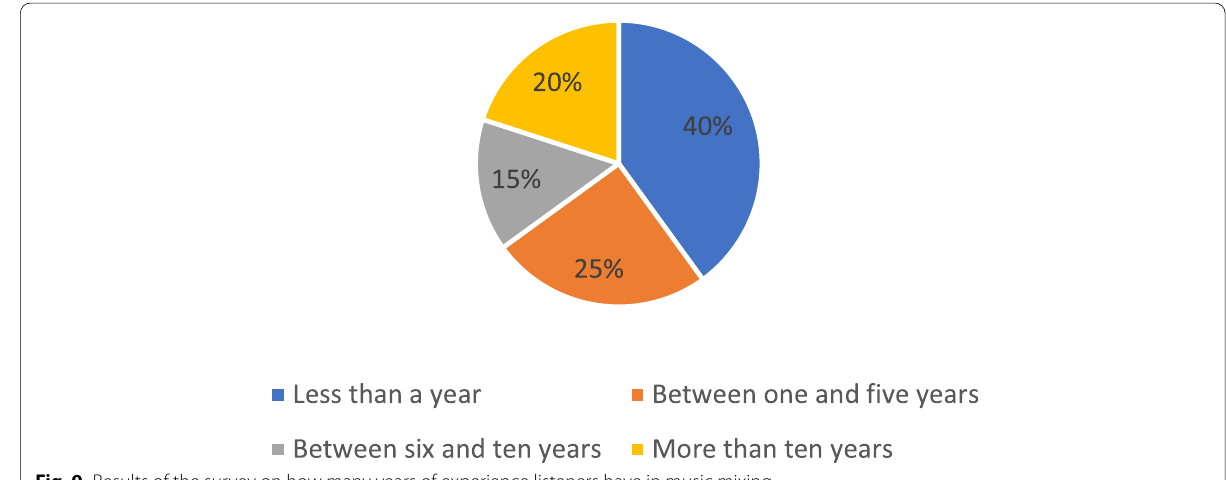
Fig. 9 Results of the survey on how many years of experience listeners have in music